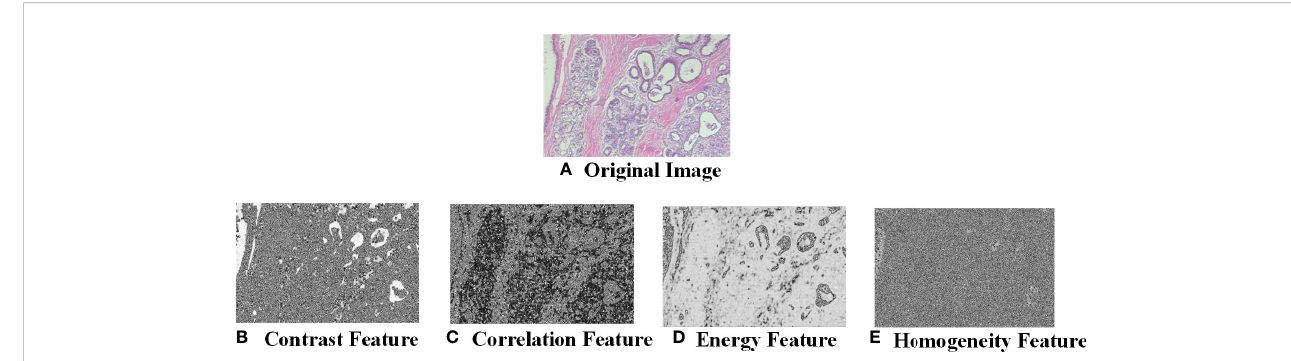
FIGURE 6 Featuremapofbreastcancerhistopathologicalimage. (A) OriginalImage; (B) ContrastFeature; (C) CorrelationFeature; (D) EnergyFeature; (E) HomogeneityFeature.